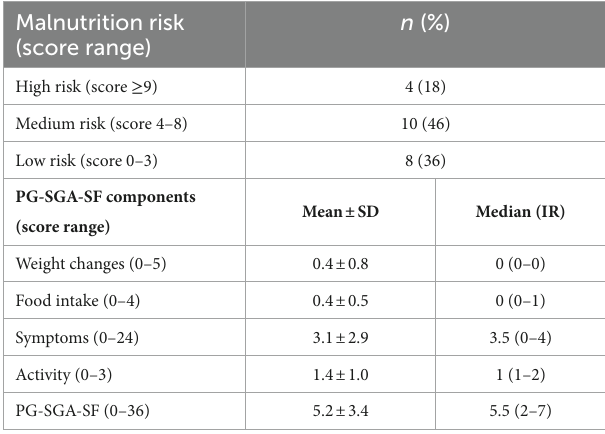
Values shown as number of cases (percentage), mean ± SD and median (interquartile range, IR). Higher score indicates more severe nutritional